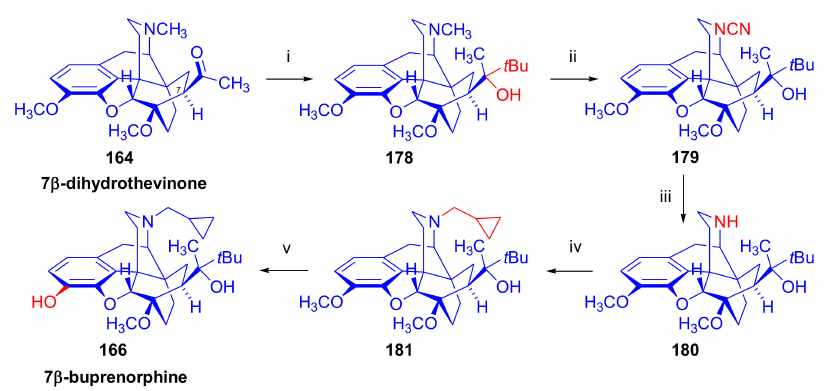
Figure 47. Synthesis of 7 β -buprenorphine from 7 β -dihydrothevinone. Reagents and conditions : (i): tert -butylmagnesium chloride, toluene-diethyl ether, 1.5 h; (ii): BrCN, CHCl 3 , room temperature, 20 h; (iii): KOH, diethylene glycol, 170 ◦ C; (iv): cyclopropylmethyl bromide, NaHCO 3 , DMF, 90–95 ◦ C, 20 h; and (v): KOH, diethylene glycol, 210–220 ◦ C, 75 min.